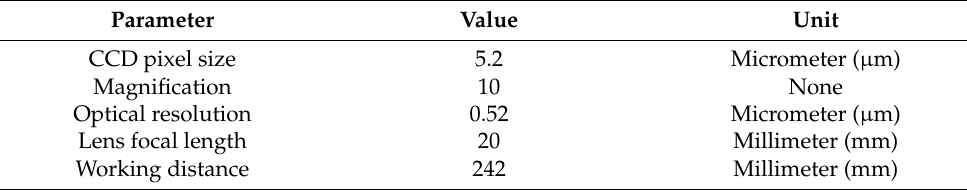
Table 1. The design of the working distance in the automatic optical inspection